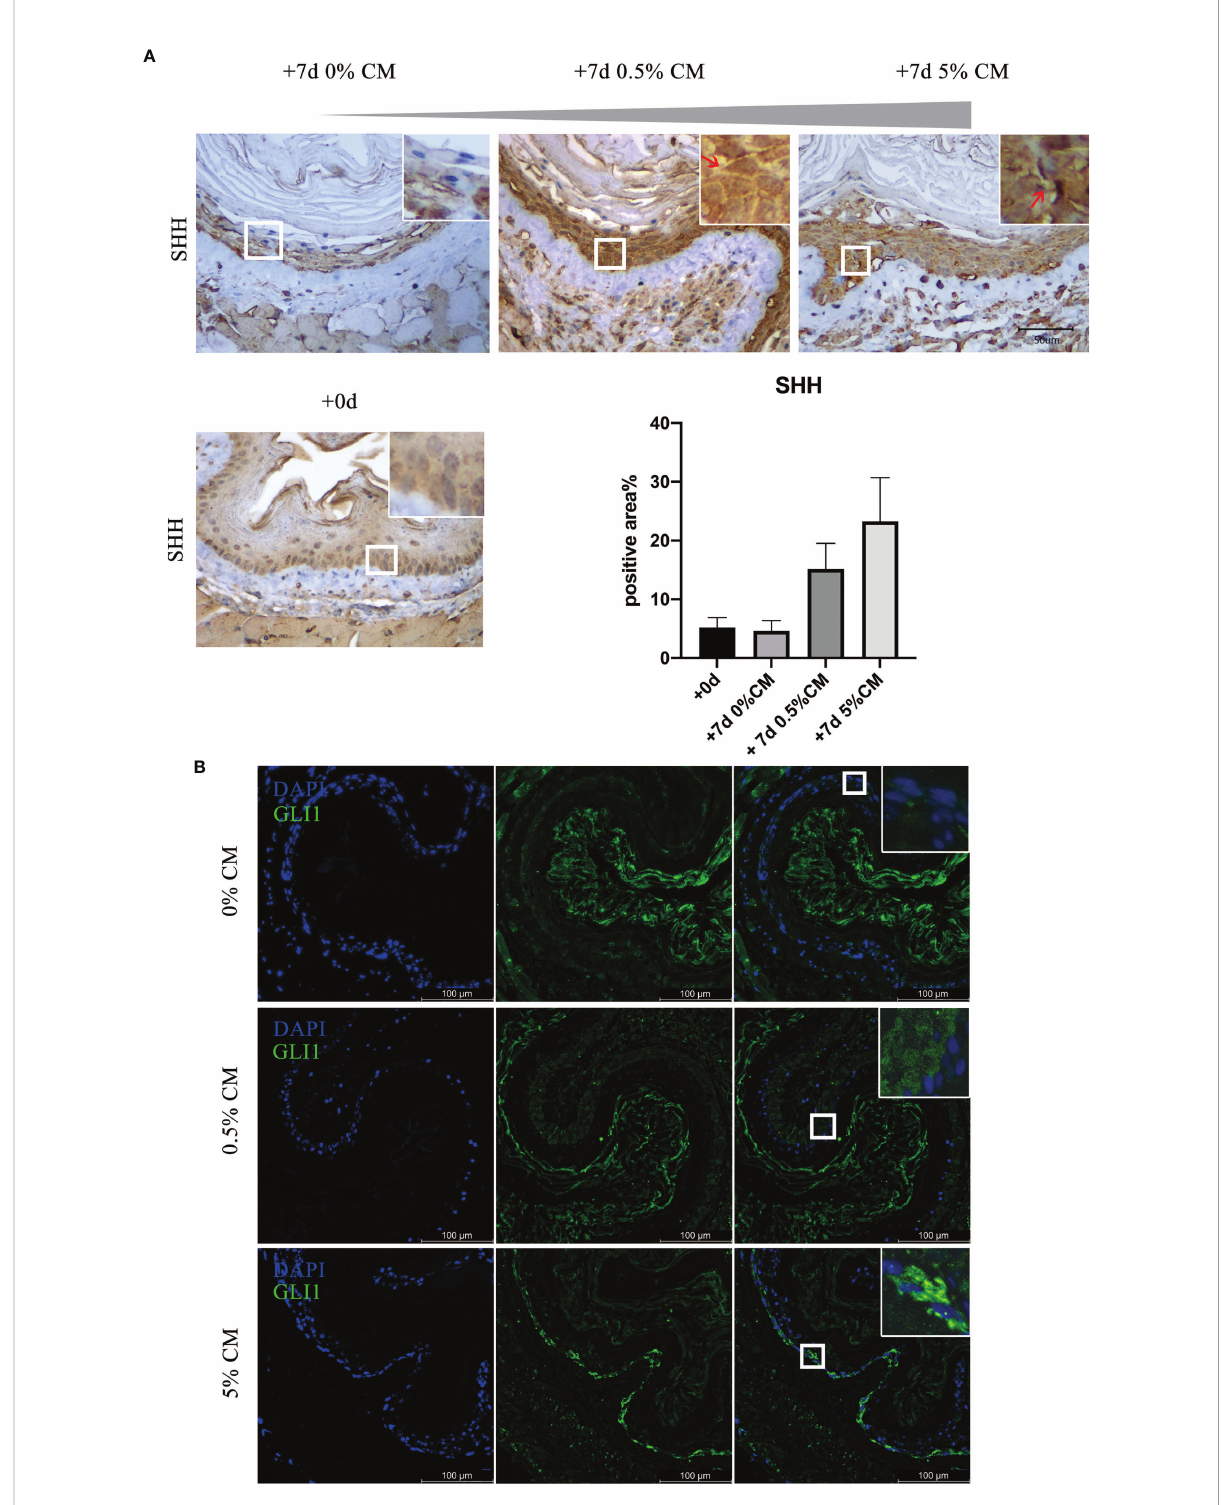
FIGURE 4 The SHH pathway was activated in P. gingivalis cultured media-treated mouse esophagi. (A) Overexpression of SHH protein in epithelial cells in 0.5% CM and 5% CM groups as indicated by red arrows. (B) GLI1 expression increased with 0.5% or 5% P. gingivalis cultured media treatment for 7 days, and the GLI protein was translocated from the cytoplasm into the nucleus of epithelial cells, especially in the 5% CM group. Scale bars: 50 m m (A) ; 100 m m (B)